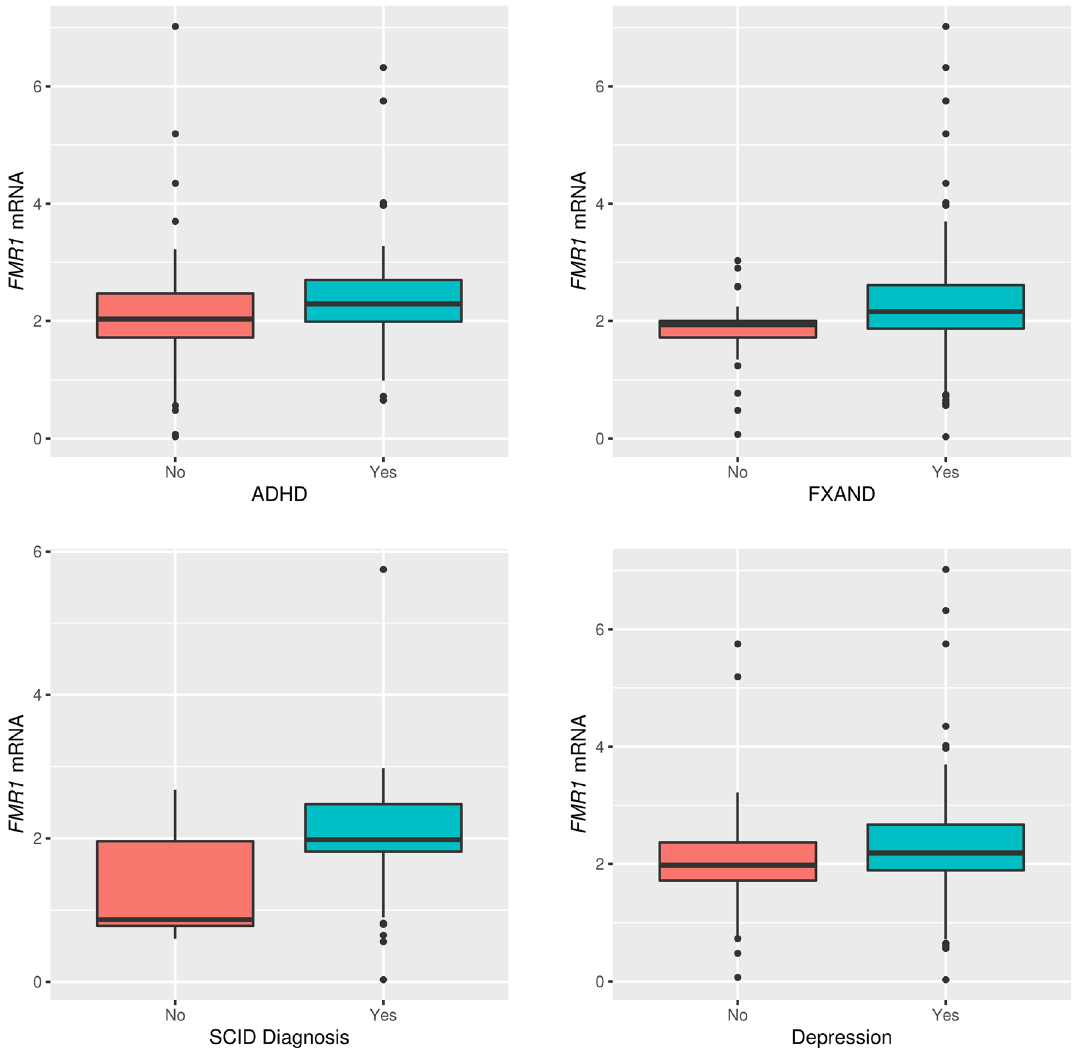
Figure 2. Significant association between FMR1 mRNA levels and the presence of clinical conditions.